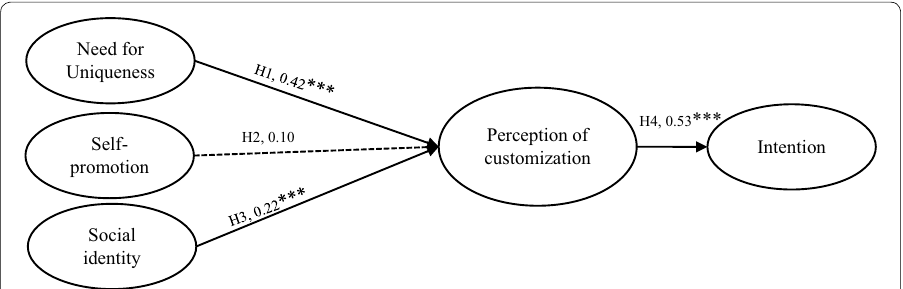
Fig. 2 SEM results of the research model. Numbers on the structural paths are standardized path coefficients; the dotted line indicates non‑significant relationship, χ 2 112.267, df 71, ρ 0.00; AGFI 0.93; GFI 0.96; = = = = = NFI 0.96; CFI 0.98; SRMR 0.04; RMSEA 0.04. ***p < 0.001, *p < = = = =